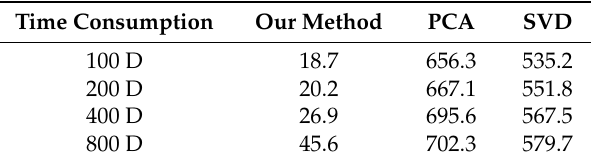
Table 6. Feature compression with three methods